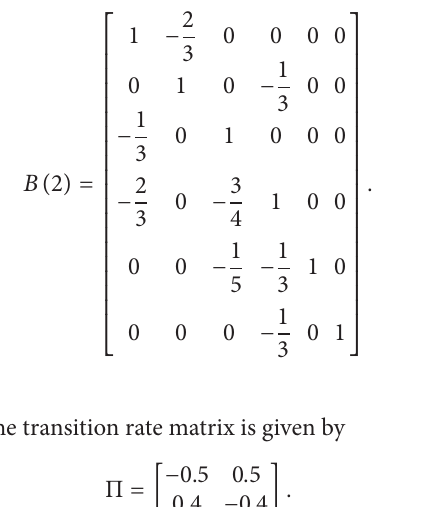
Figure 2 is one of the possible realizations of the Markovian jumping mode. For a given small prescribed 𝐻 ∞ disturbance attenuation level 𝛾 = 2.5 , by solving condition (14) in Theorem 1 with the proposed mixed algorithm proposed in [20, 21], a set of feasible state feedback control parameters can be obtained as 𝑘 1𝑖 = −1.9, 𝑘 2𝑖 = −1.5 . The initial error inventory level ̂𝑦 𝑖 (0) is chosen randomly from the interval [−5, 5] , and the initial error delivery rates ̂𝑥 𝑖 (0) are chosen randomly from the interval [−1, 1] . Suppose that 𝑤 𝑖 (𝑡) = 0.1 sin (𝑡)/𝑡 and the average demand rates 𝑑 = [𝑑 1 , 𝑑 2 , . . . , 𝑑 6 ] = of the error states of supply networks without control, which shows that the supply network is not stable at the stationary states. Under the control (10), the evolution curves of the error states of supply networks depicted in Figure 4, from which we can see that under control (10), the supply networks model (8) realizes the robust stabilization at the stationary states at 𝑡 = 20 . The simulations show the effectiveness of the proposed methods in this